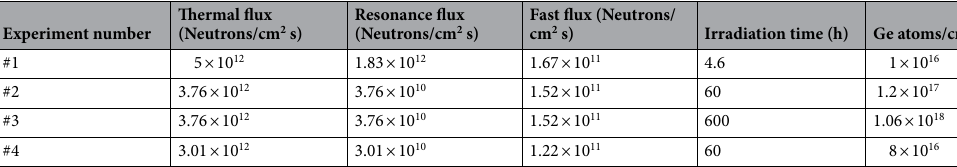
Table 1. Experimental parameters.